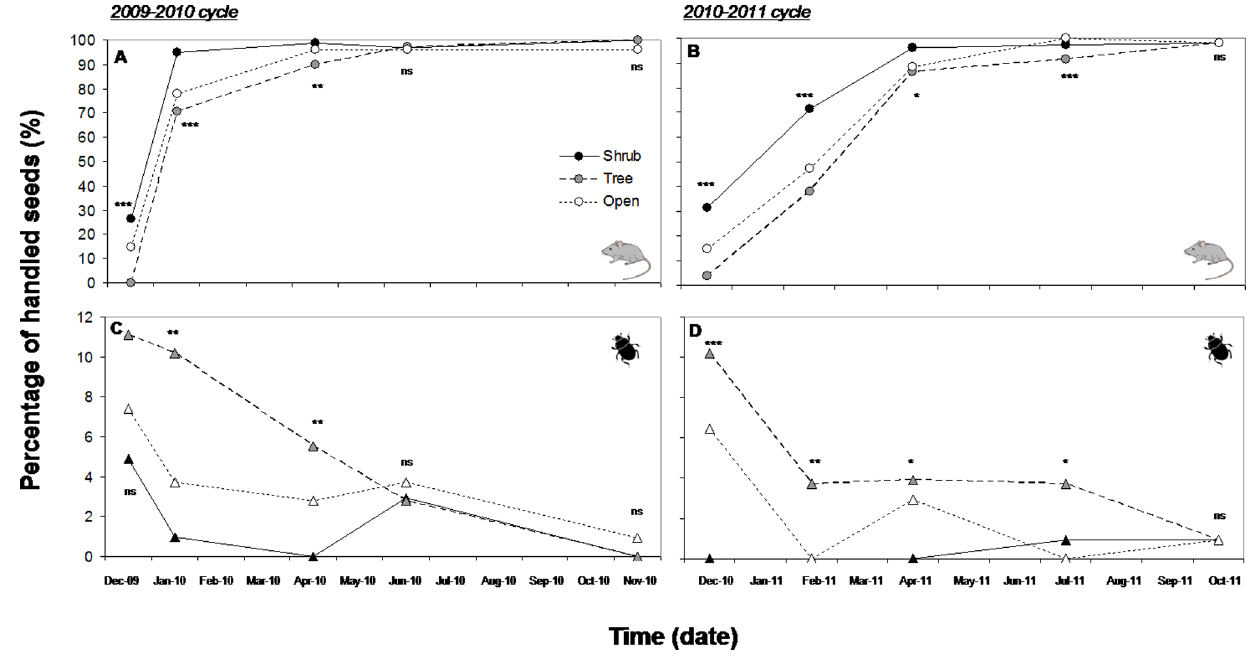
Figure 1. Temporal dynamics of seed handling by rodents and beetles during the two sampling years. Significant differences among the three types of microhabitat considered in this study are indicated as follows: *p , 0.05; **p , 0.01; ***p , 0.001; ns not significant.